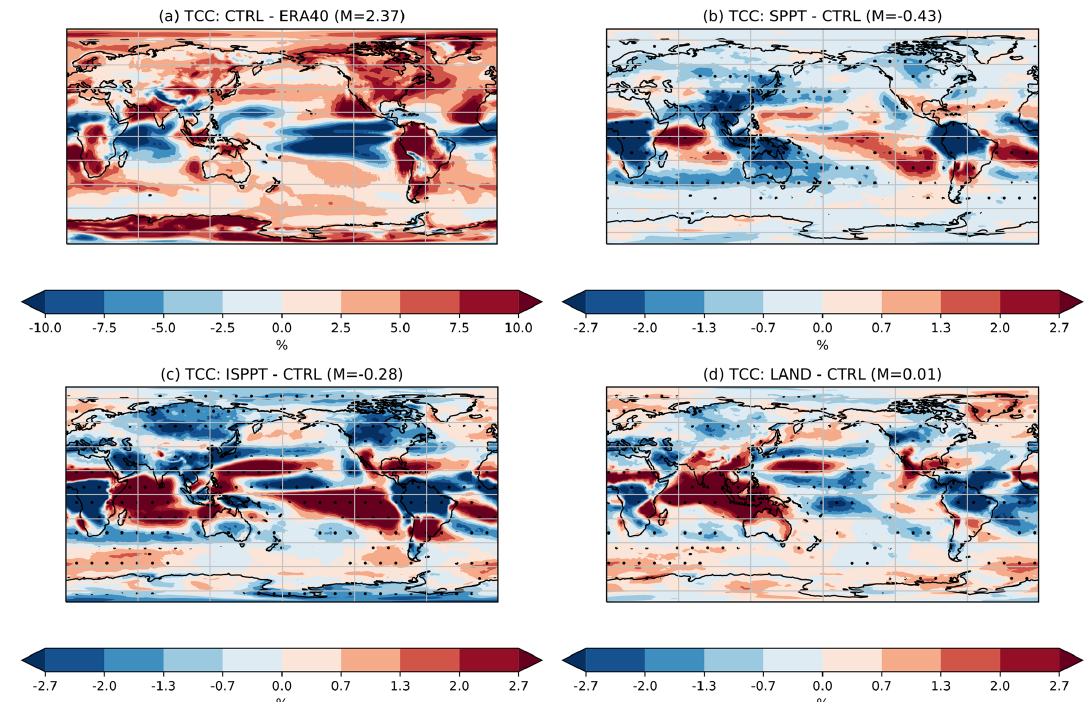
Figure 4. Mean differences in total cloud cover between the (a) CTRL and ERA40, (b) SPPT and CTRL, (c) ISPPT and CTRL, and (d) LAND and CTRL. Stippling indicates regions where the difference is statistically significant to the 95% confidence interval, as measured by a two-tailed t test. In each panel, M denotes the mean of the difference. Note the difference in the scales between (a) and (b, c, d) . The percentage (%) units indicate the proportion of the column occupied by